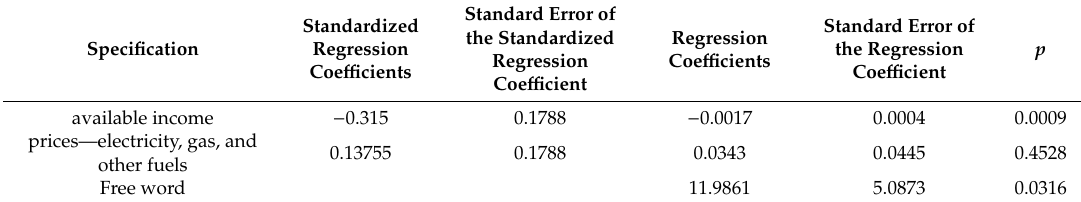
Table 2. The impact of available income and changes in the prices of energy carriers on the share of expenditure on energy carriers in Polish one-person households in 2000–2018.